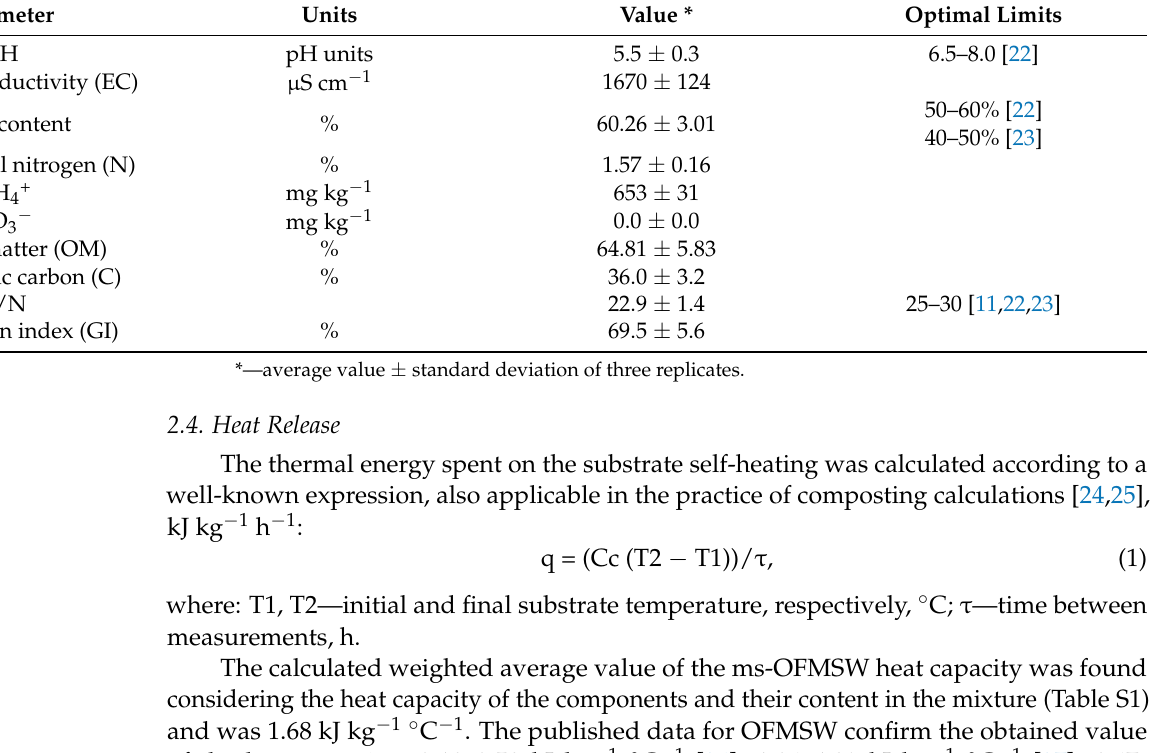
Table 1. The principal physical, chemical, biological, and physicochemical parameters of the initial ms-OFMSW. Parameter Units Value * Optimal Limits pH pH